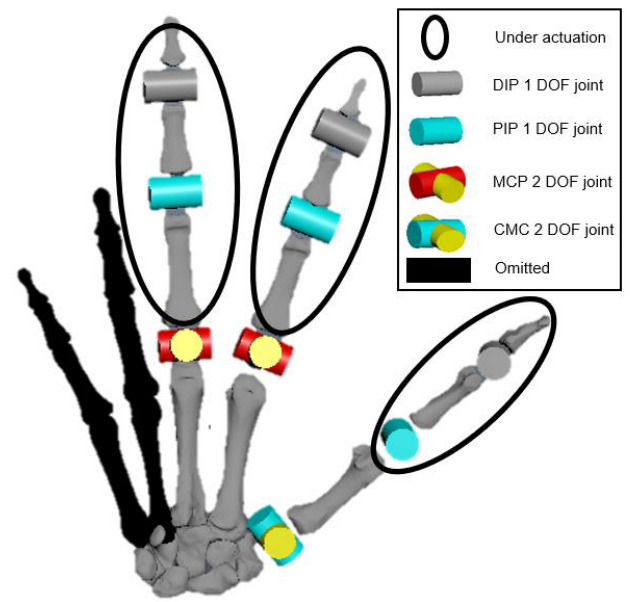
Figure 8. The simplified 9-DOF model of the proposed hand. Each joint is driven by corresponding tendons. Based on Landsmeer’s model III [44], the basic equation for modeling the tendon displacement ( L ) can be simplified to a second- order polynomial approximation [45]: